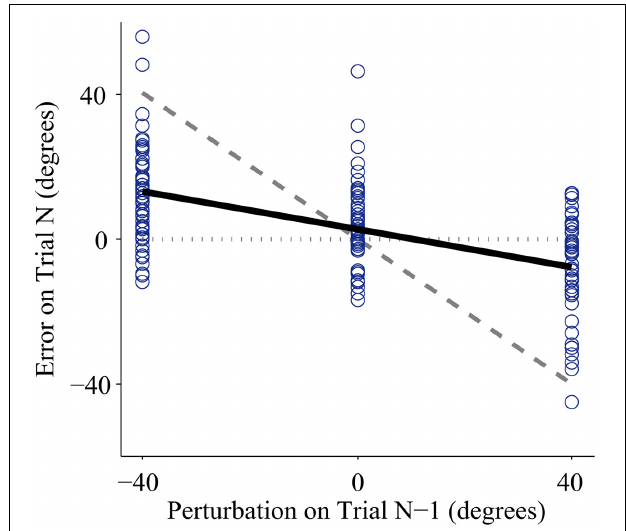
FIGURE 2 | Representative data from one subject using the joint angle control interface with low feedback uncertainty. Individual trials are plotted as circles. The x-axis shows the perturbation size for a trial with one-dot terminal feedback, and the y-axis shows the error on the following trial (error is defined as the unperturbed or true distance between the cursor and the target). Adaptation rate is defined as the slope of the linear regression between the unperturbed error of trial (N) and the perturbation of trial (N-1). The regression is plotted as the bold solid line. If a subject showed no adaptation, the regression slope would equal zero, illustrated by the horizontal dotted line. If a subject showed complete adaptation, the regression slope would equal − 1, illustrated by the dashed line. Note that the adaptation rate is negative; however, in this paper we present adaptation rates as positive values to avoid confusion.